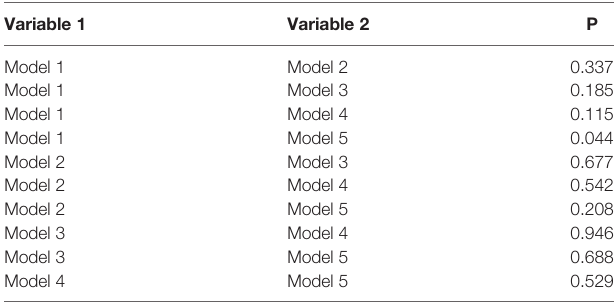
TABLE 3 | P values of the fi ve radiomics model obtained by Delong ’ s